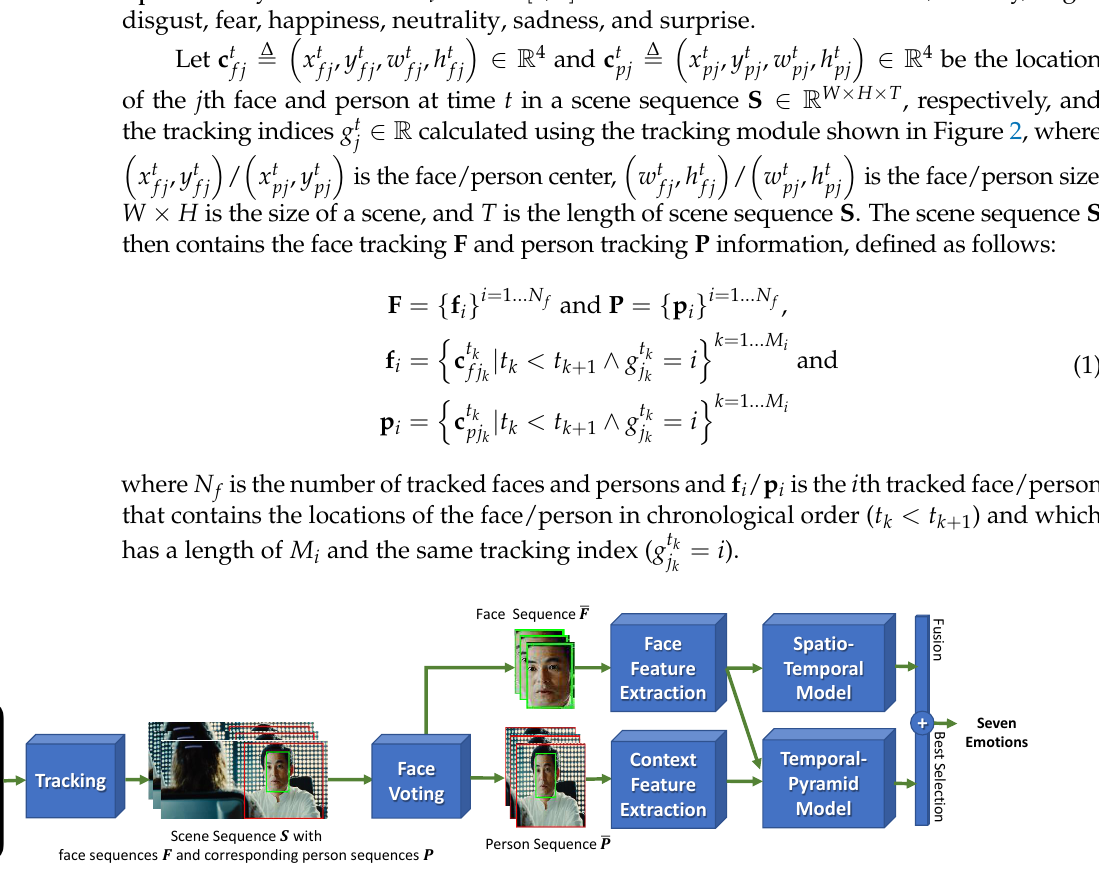
Figure 2. Overview of the proposed system for video emotion recognition in the